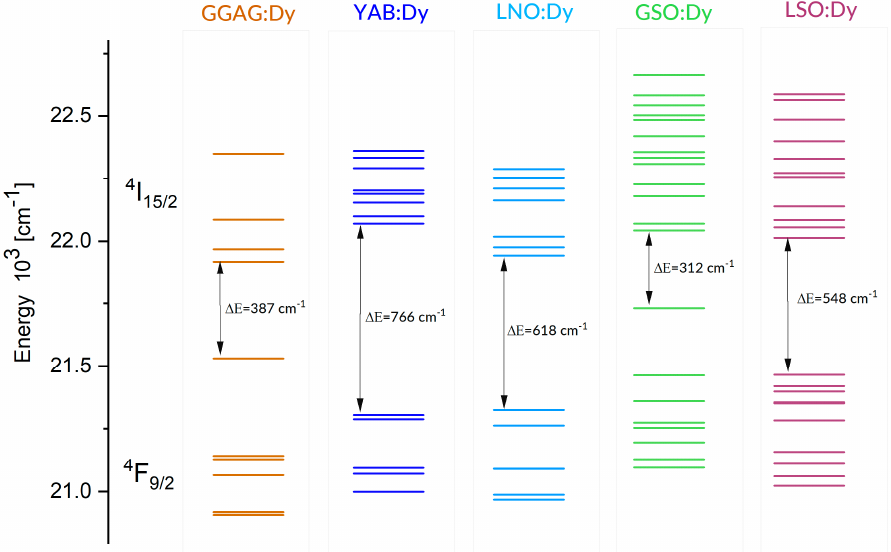
Figure 11. The crystal field splitting of the 4 I 15/2 and 4 F 9/2 multiplets of Dy 3+ , determined based on low temperature absorption spectra.